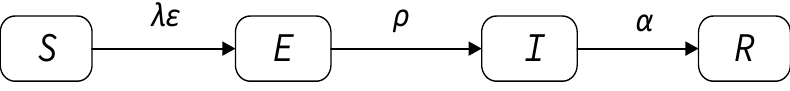
Figure 1. The transition between states of SEIR model.